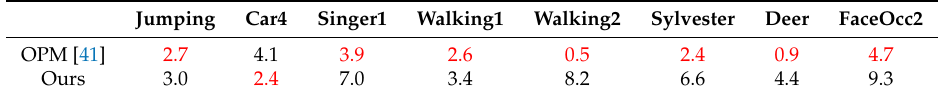
Table 6. Average center location error comparison with occlusion probability mask-based tracker (OPM) [41] on some sequences in OTB-100. The red number is the best result.